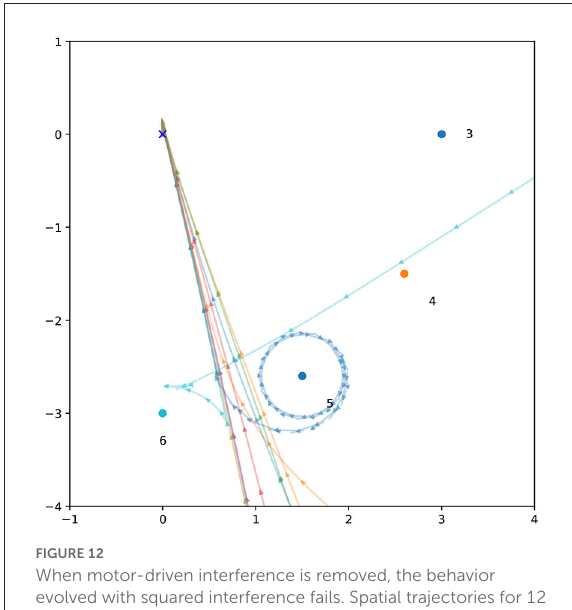
FIGURE12 When motor-driven interference is removed, the behavior evolved with squared interference fails. Spatial trajectories for 12 light coordinates (Figure 3) are plotted with all motor-sensor interference removed. The approach phase now only succeeds in two out of 12 cases, where the blind approach brings the robot close to the light. The orbit phase only succeeds in one of these two